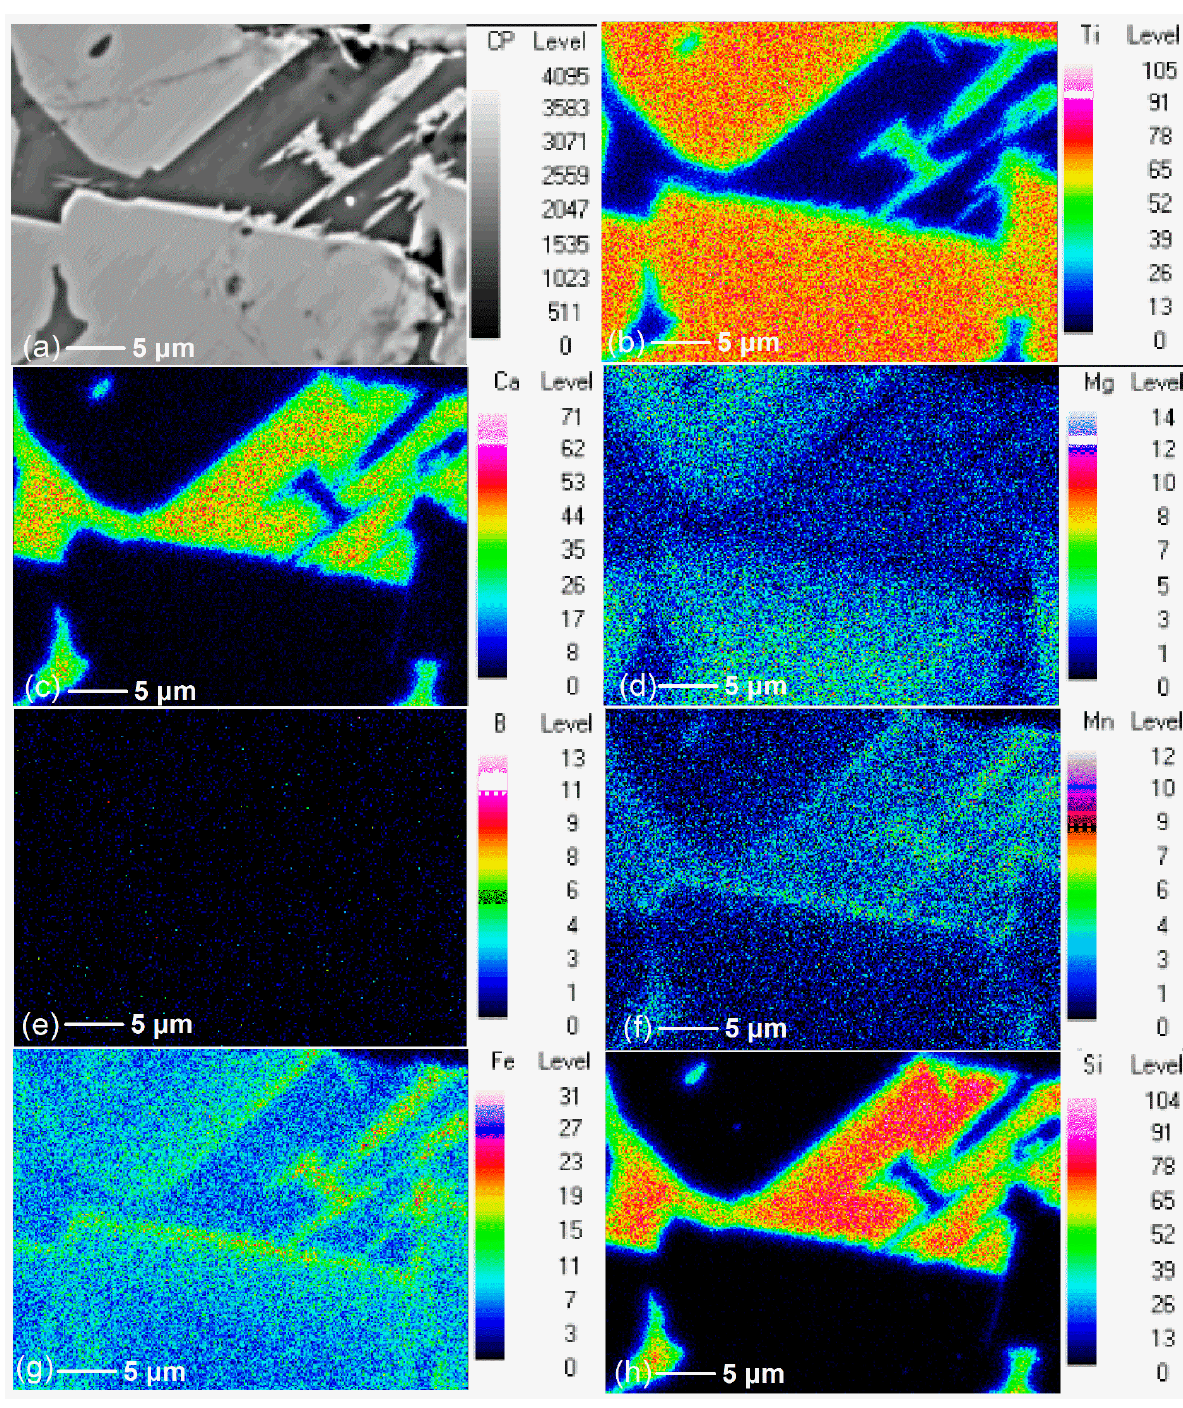
Figure 3. WDS mapping analysis of the cross-section of block sample of the modified titanium slag with the additive (B 2 O 3 ) amount of 0%: ( a ) total, ( b ) Ti, ( c ) Ca, ( d ) Mg, ( e ) B, ( f ) Mn, ( g ) Fe, and ( h ) Si.